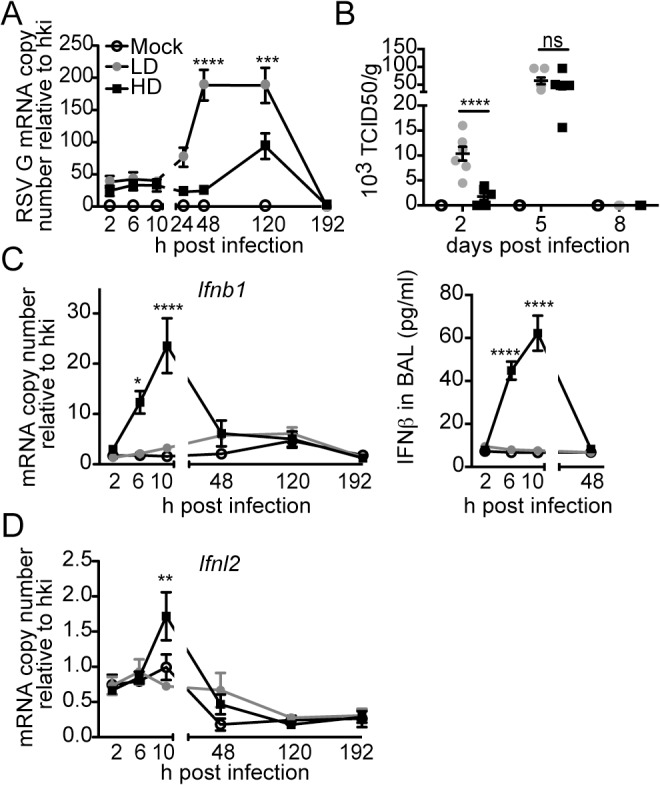
RSV iDVGs rapidly induce an antiviral response that controls viral load in mice.Balb/c mice were infected intranasally with 5 x 106 TCID50/mouse of RSV-LD or HD, or mock infected. Expression of (A) RSV G mRNA and (B) virus titer in whole lung homogenates at the indicated time points. (C) Ifnb1 mRNA and IFNβ protein in the bronchoalveolar lavage (BAL). (D) Expression of Ifnl2 in whole lung homogenates. Error bars indicate mean ± SEM of individual measurements in two pooled independent experiments each with triplicate technical measurements. (n = 7–9 mice per group total; *p<0.05, **p<0.01, ***p<0.001, ****p<0.0001 by two-way ANOVA with Bonferroni’s post hoc test). Gene expression is shown as copy number relative to a house keeping gene expression index determined from the expression of Rps11 and α-tubulin.